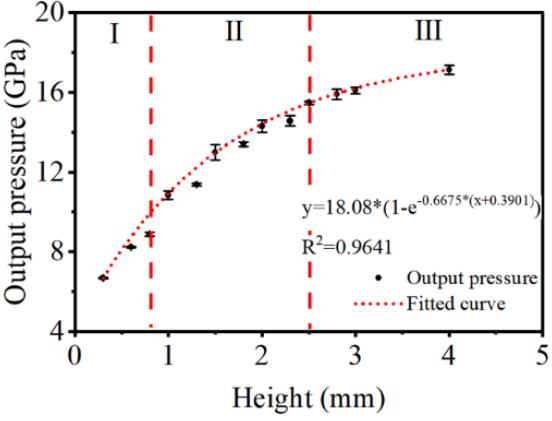
Figure 6. Output pressure as a function of charge height.